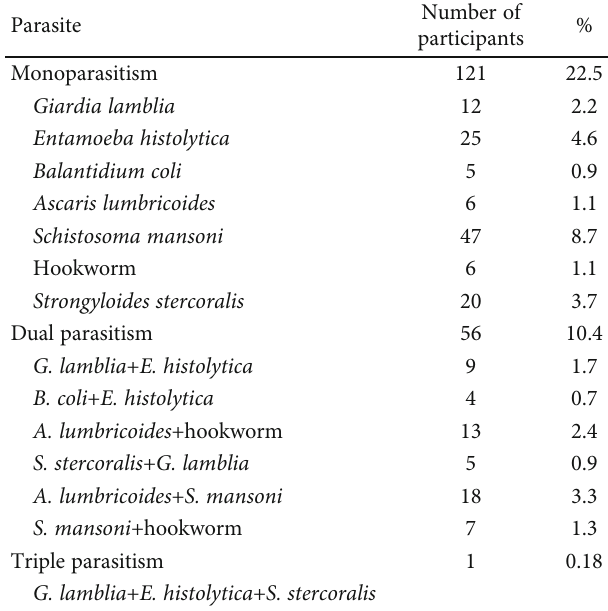
Table 3: Prevalence of single and coparasitism in study